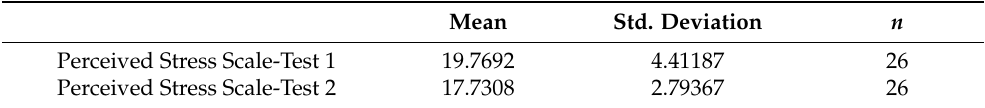
Table 5. Mean results for Perceived Stress Scale for the ANCOVA model for Group I pre-test/Trial-1 and post-test/Trial-2 measurements. Mean Std. Deviation n Perceived Stress Scale-Test